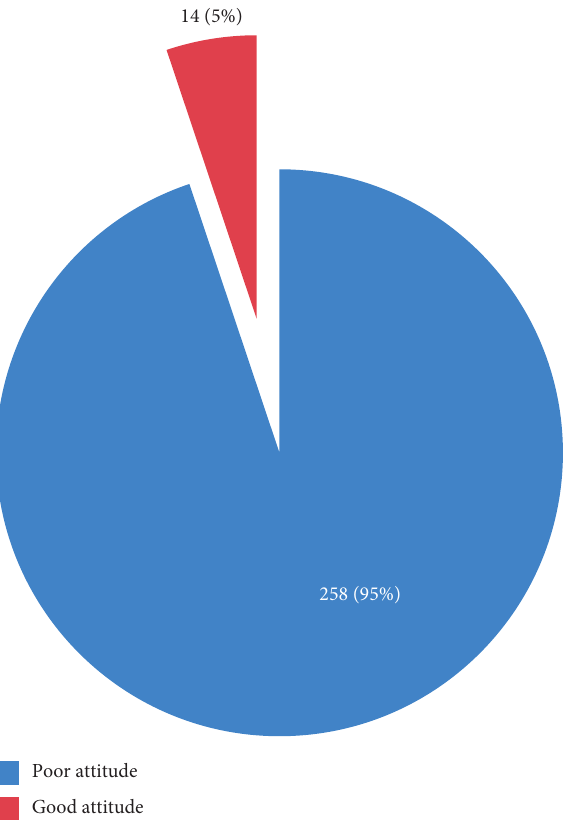
Figure 1: Attitude of respondents towards personal protective